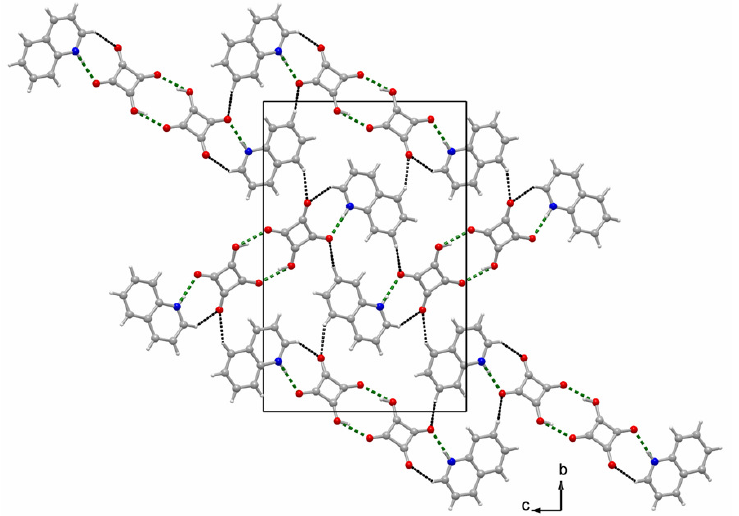
Figure 2. The unit cell packing diagram of the title compound projected along the a axis, showing dimerization of the HqnHsq formula units via lateral N-H...O and C-H...O bonds (dotted lines), closely similar to the side-by-side sheets arrangement of [Ni(bdt) structure of [NBu ][Ni(bdt) ] 14 (bdt 2- = benzene-1,2-dithiolate) 4 2 Table 3. Intermolecular interactions (Å,°) for the title compound